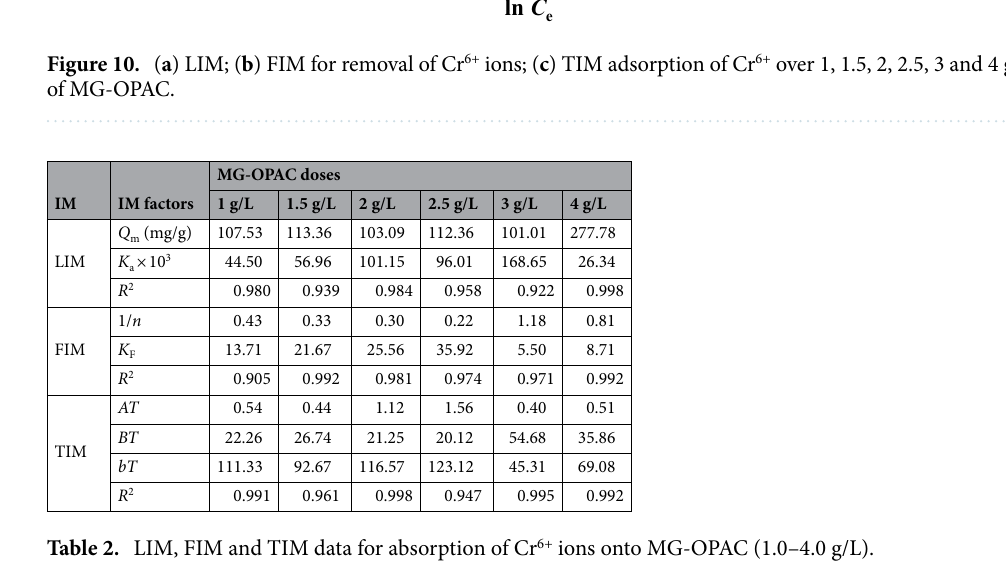
Table 2. LIM, FIM and TIM data for absorption of Cr 6+ ions onto MG-OPAC (1.0–4.0